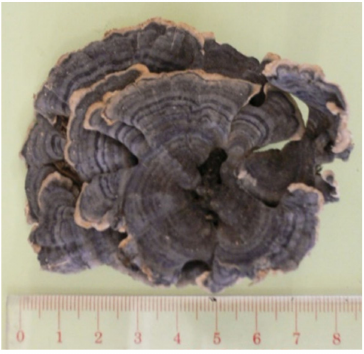
Figure 1. Coriolus versicolor